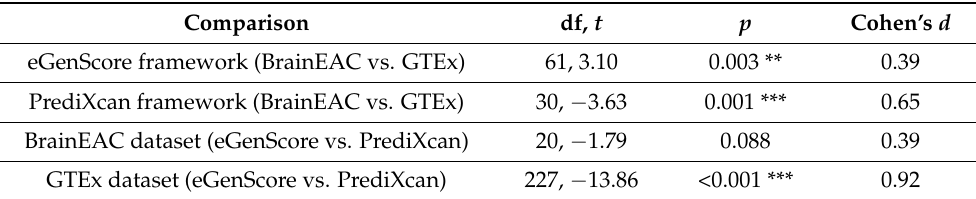
Figure 4. Comparison of the squared averaged Pearson correlation coefficient ( r avg 2 ) between the predicted and observed gene expressions during the internal cross-validation across databases (i.e., BrainEAC vs. GTEx) using the eGenScore ( A ) or the PrediXcan ( B ) framework and across frameworks (i.e., eGenScore vs. PrediXcan) using the BrainEAC ( C ) or GTEx ( D ) dataset. The model’s performance is represented with a filled black or hollow gray marker if trained with the BrainEAC or GTEx database, respectively, and with a circle or triangle if trained with the eGenScore or PrediXcan framework, respectively. Table 1. Comparison of the gene expression models’ internal validation performance (i.e., the squared averaged Pearson correlation coefficient between the predicted and observed gene expressions) across datasets (i.e., BrainEAC vs. GTEx) and across frameworks (i.e., eGenScore vs.